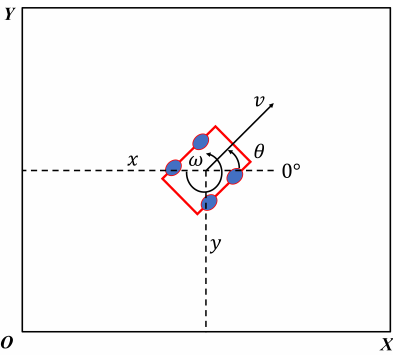
Figure 2. Model of the UGV.